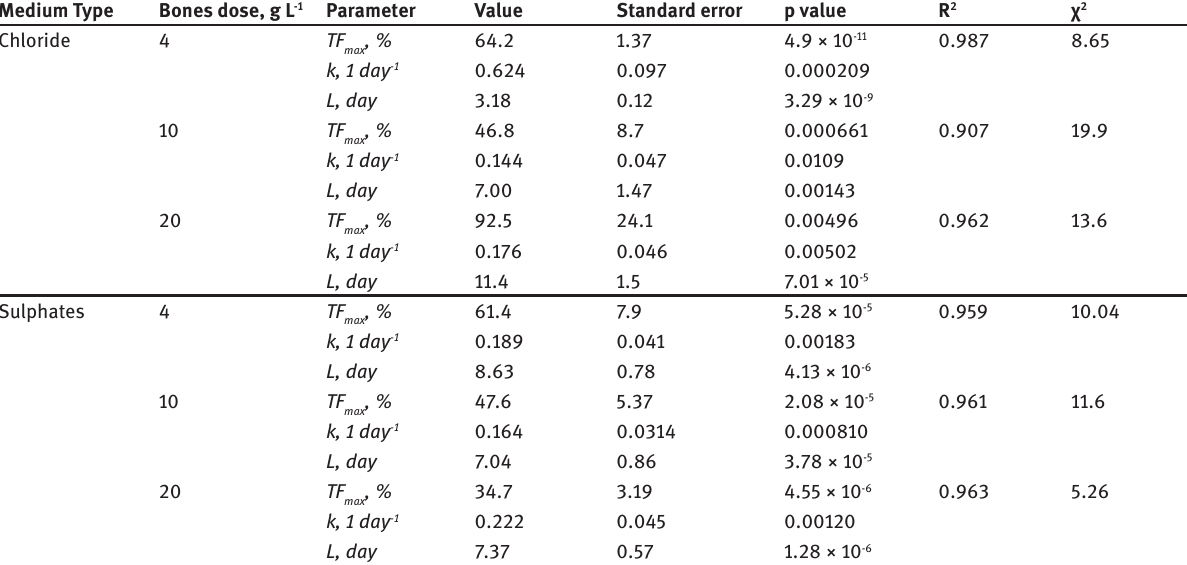
Table 3: The parameters of the model describing the change in the Solubilization Factor during the solubilization